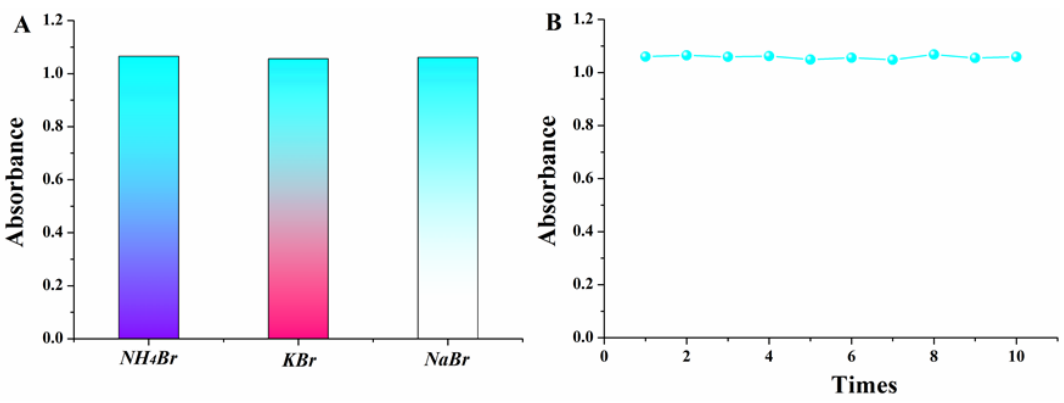
Figure 4. ( A ) Dependence on the bromine source and ( B ) reutilization test of the N-C/CeO 2